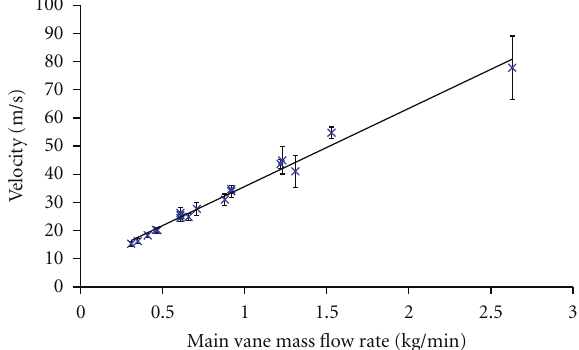
Figure 12: Mean velocity in the main channel measured at 75% of the main channel depth away from the cross flow for experimental plane three (9mm from the combustion